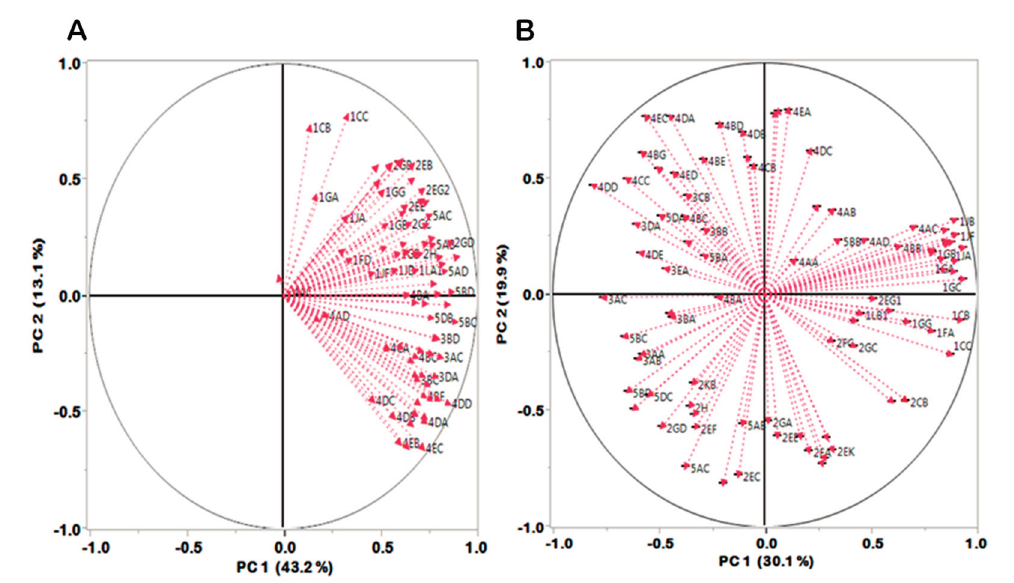
Figure 3. Loading plots of ( A ) untransformed data—Raw; ( B ) centered log-ratio (clr) transformed annual NDVI data. In the untransformed data, the rays representing the 88 sub-watersheds are clustered towards one direction. After transformation, substantial spread of rays in all directions was attained, and with smaller clusters of sub-watersheds showing varied response to changes in vegetation greenness. Longer and closely packed rays in upper right (UR) quadrant indicate a remarkable variation and correlation in NDVI by sub-watersheds within the Lake Victoria Basin